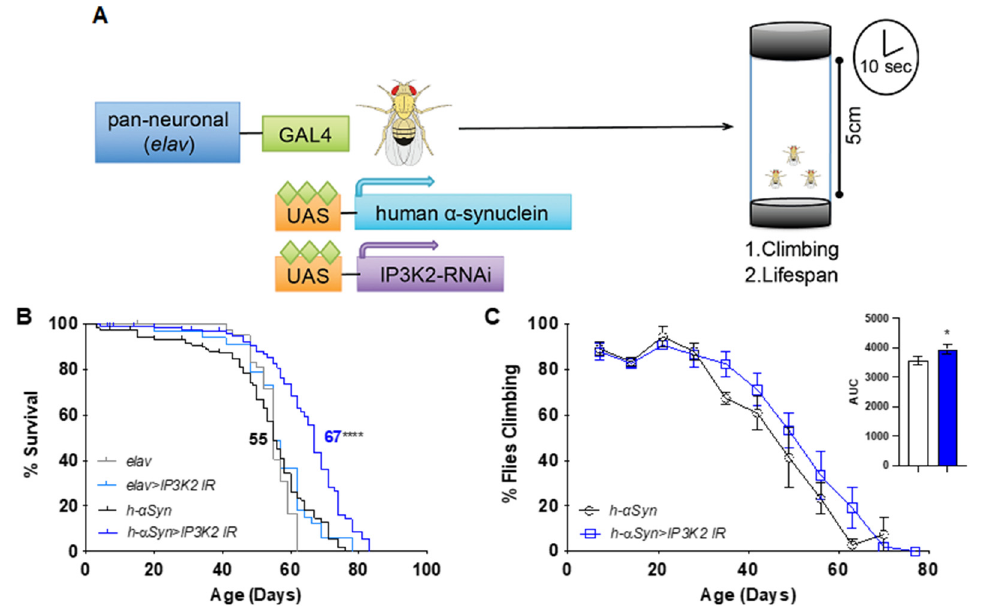
Figure 1. Neuronal knockdown of IP3K2 increases lifespan and climbing in h- α Syn expressing flies. ( A ) Neuronal knockdown ( elavGal4 ) of ITPKB ortholog, IP3K2 was tested for its modification of h- α Syn phenotypes, climbing and lifespan. ( B ) Knockdown of IP3K2 increased lifespan in an h- α Syn -dependent manner. ( C ) Climbing ability of IP3K2 knockdown ( h- α Syn > IP3K2 IR ) was slightly increased compared to the PD model ( h- α Syn ; N = 3; each n ≥ 40 animals). Data represent mean ± SEM. p -values calculated using log-rank Mantel-Cox test ( B ) and area under the curve analysis ( C ). * p < 0.05; **** p < 0.0001. elav = elavGal4/+ ; +/+ ; UAS-mCD8GFP/+ . elav > IR = elavGal4/+ ; UAS-IR/+ ; UAS-mCD8GFP/+ . h- α Syn = elavGal4/+ ; +/+ ; UAS-h- α Syn/+. h- α Syn > IR = elavGal4 ; UAS-IR/+ ; UAS-h- α Syn .